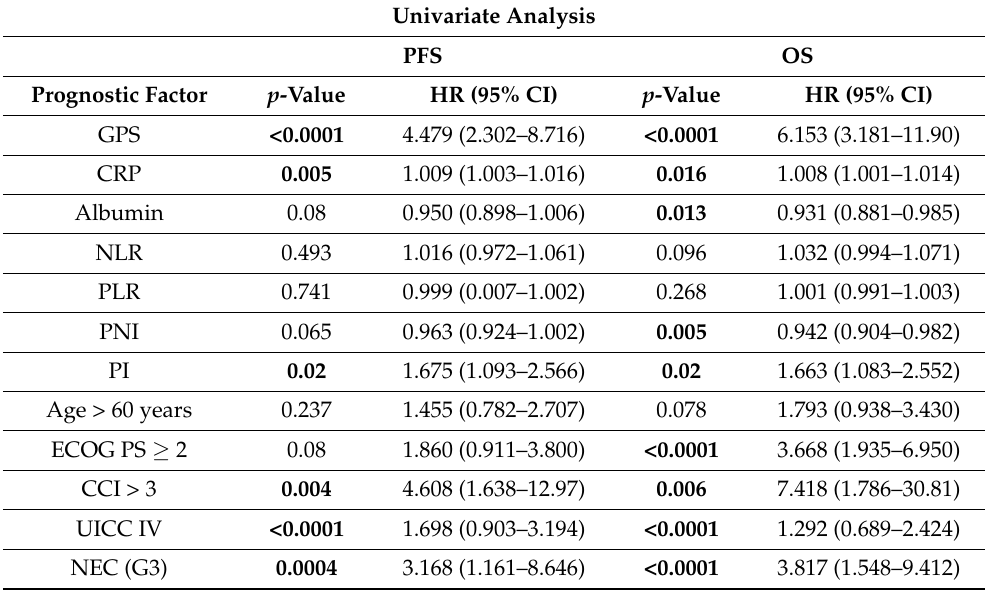
Table 4. Progression-free and overall survival in the univariate analysis (Univariate cox analysis).